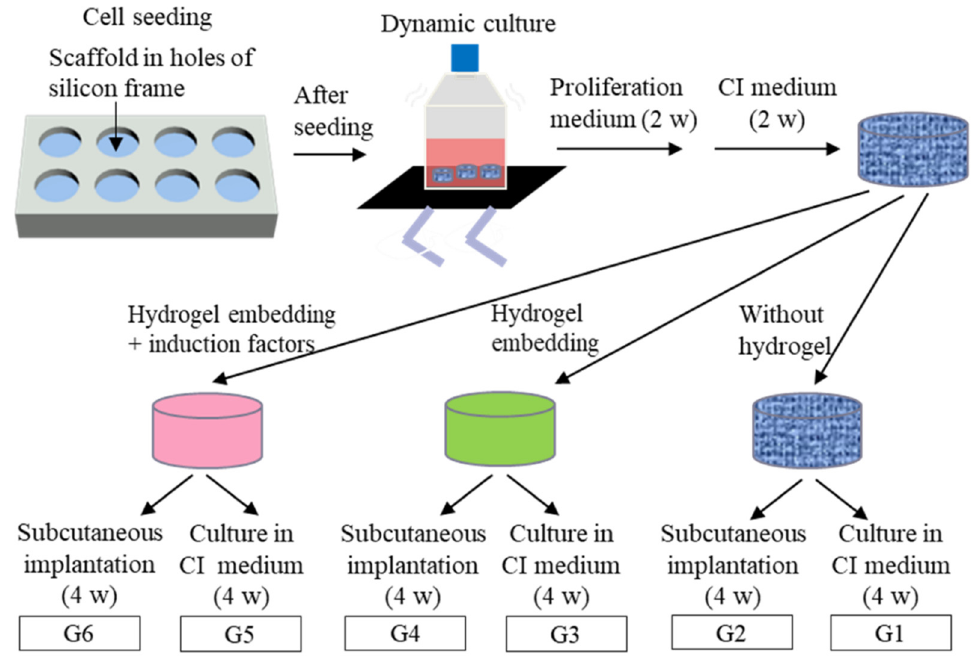
Figure 3. Scheme of in vitro cell culture and in vivo implantation of different samples.